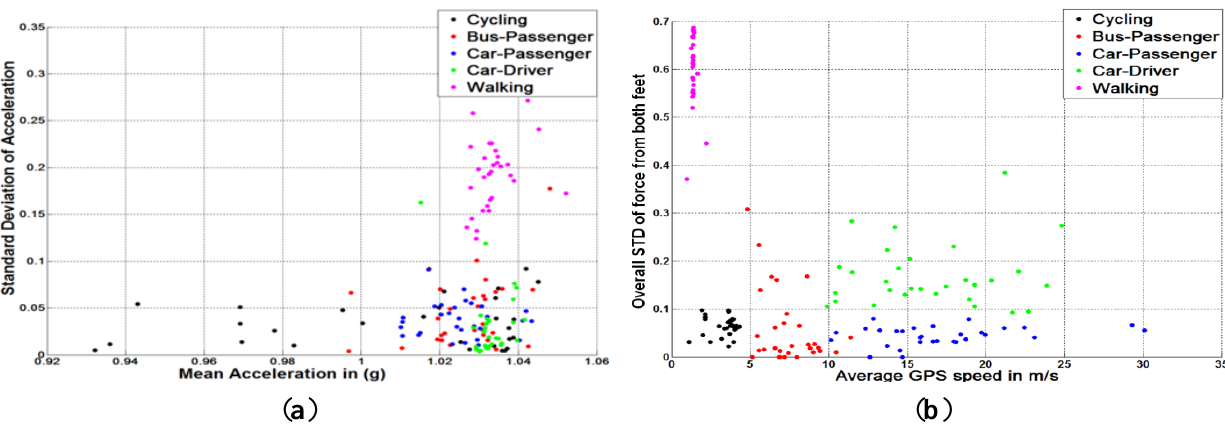
Figure 4. Clustering results of 120 samples from five transportation modes